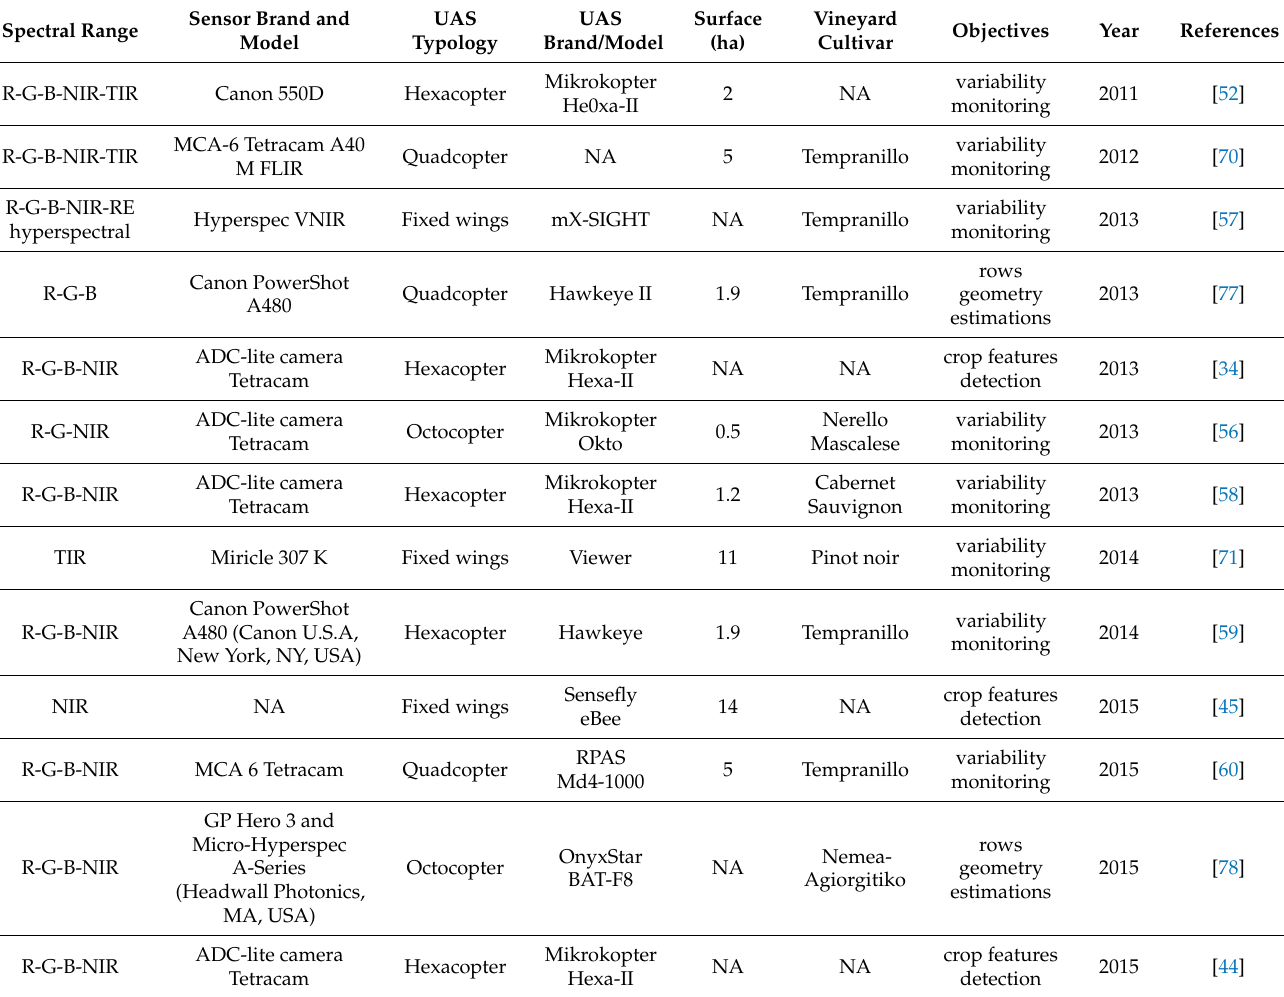
Table 1. Unmanned aerial system (UAS) typology used for viticulture research purposes and sensors information. Sensor Brand and Spectral Range